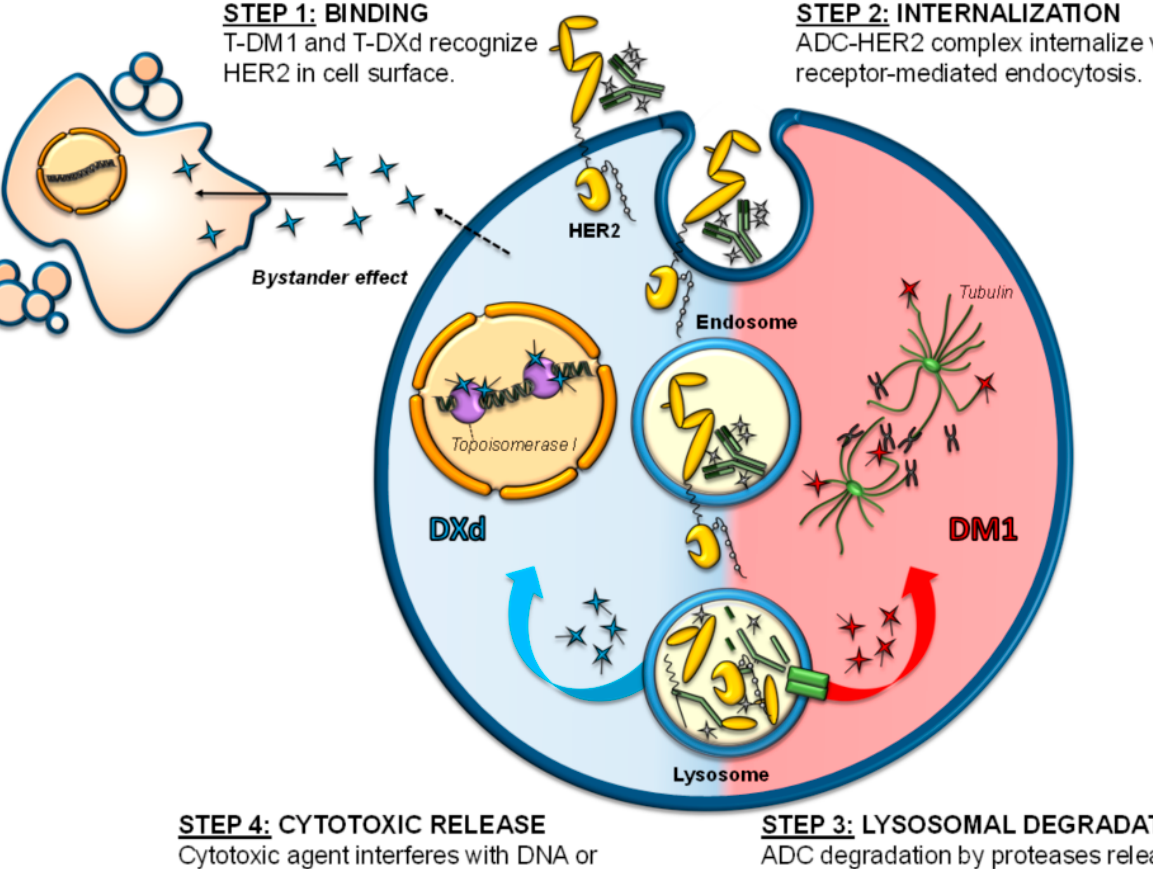
Figure 2. Mechanism of action of anti-HER2 ADCs. The figure schematizes the different steps involved in the action of anti-HER2 ADCs, which include: ( step 1 ) binding of the ADC to HER2, ( step 2 ) internalization of the ADC-HER2 complex, ( step 3 ) lysosomal degradation of the ADC, and ( step 4 ) release of the payloads to the cytosolic compartment. DM1 inhibits microtubule polymerization by targeting tubulin, while DXd moves to the nucleus causing DNA damage by targeting topoisomerase I.